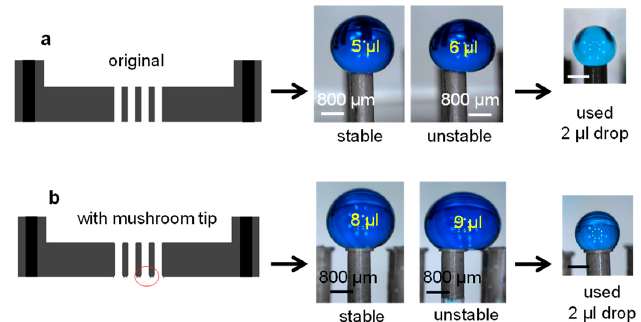
Figure 2. Extending the operational droplet volume. Central part of the mold used for fabrication of the nozzles and images of maximum droplet volumes supported by the tips ( a ) normal and with ( b ) extended mushroom-like tip.